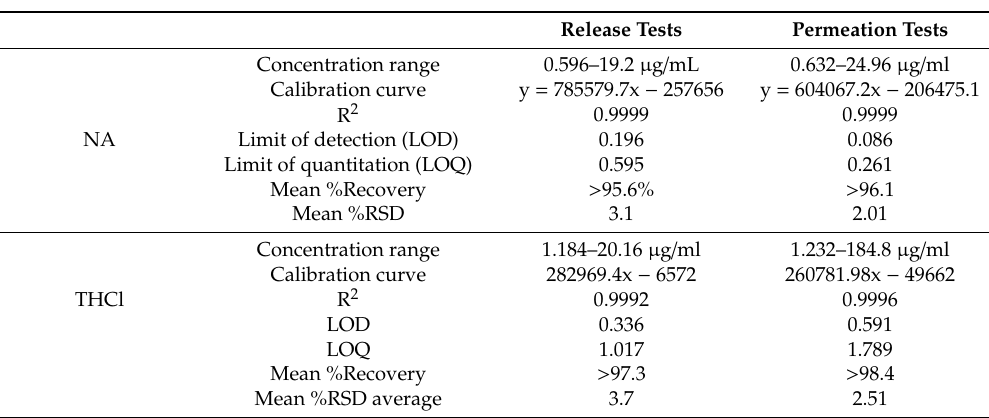
Table 8. Data analysis of validation